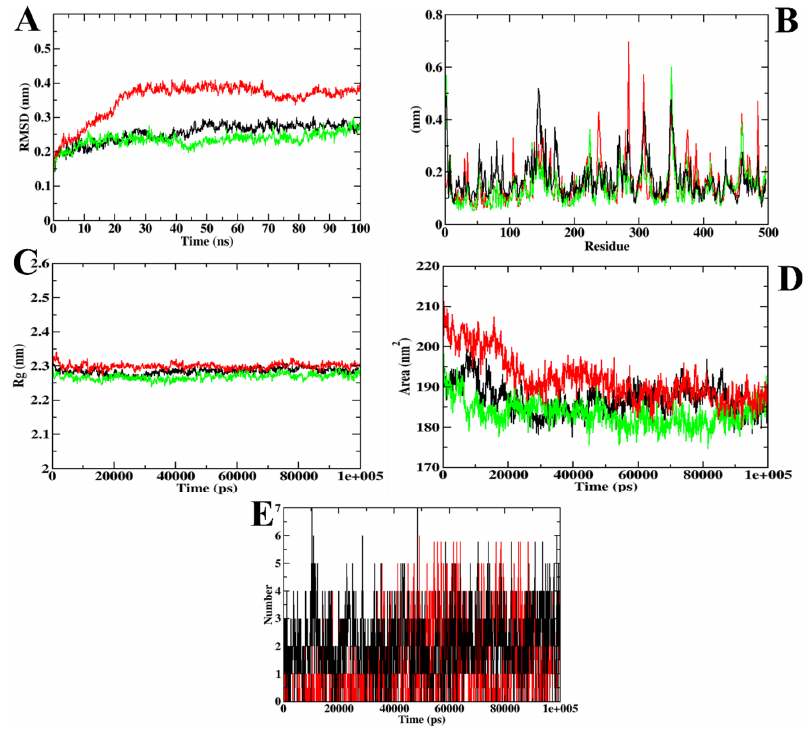
Figure 4. Visualization of MD trajectories obtained for CD-59 and acarbose complexed with α -amylase; ( A ) RMSD, ( B ) RMSF, ( C ) Rg, ( D ) SASA, and ( E ) SASA. Green: apoprotein, red: protein–acarbose complex, and black: protein–CD-59 complex.